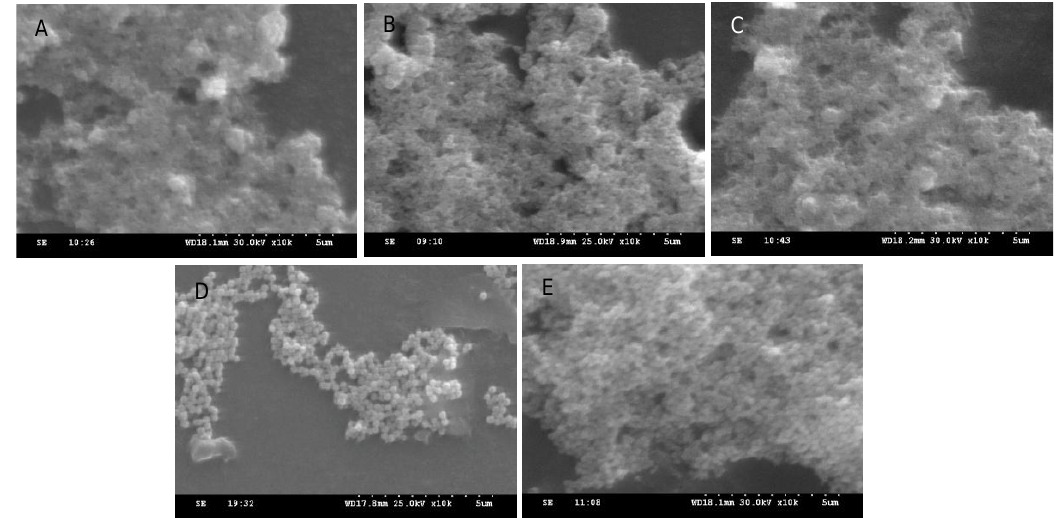
Figure 5. SEM images of Fe 3 O 4 with different molar ratio of NaAc, ( A ) 5 mmol; ( B ) 10 mmol; ( C ) 20 mmol; ( D ) 40 mmol; ( E ) 60 mmol.